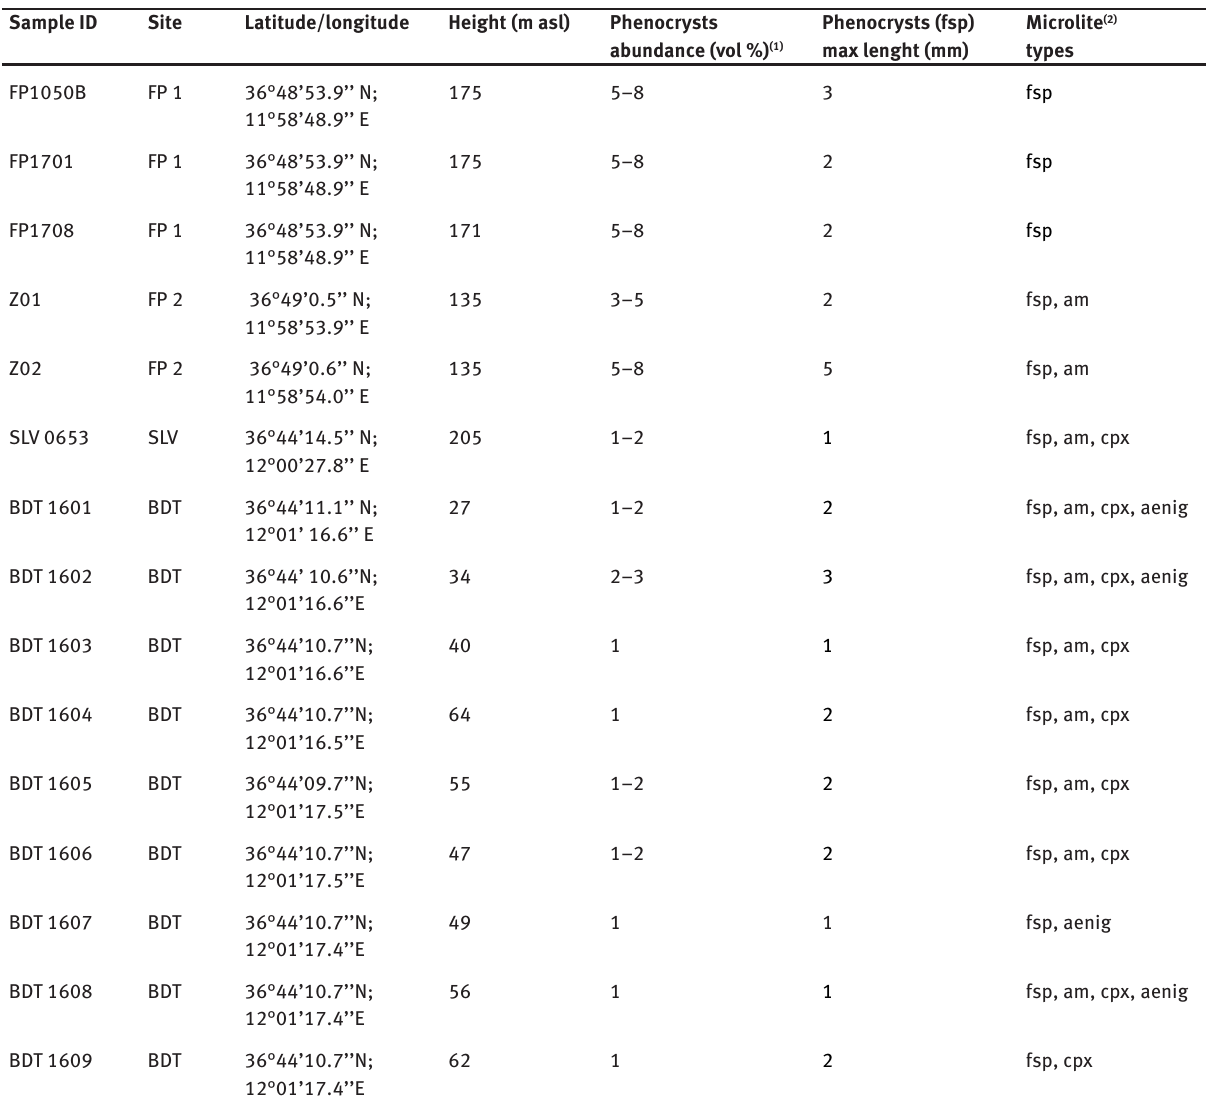
Table 1: Sample localities and principal petrographic features. Fossa della Pernice (FP) ; Salto La Vecchia (SLV) ; Balata dei Turchi (BDT) . Feld- spar (fsp), Amphibole (am); Clinopyroxene (cpx); Aenigmatite (aenig). (1) Phenocrysts (> 0.5 mm) (2) Microlites (< 50